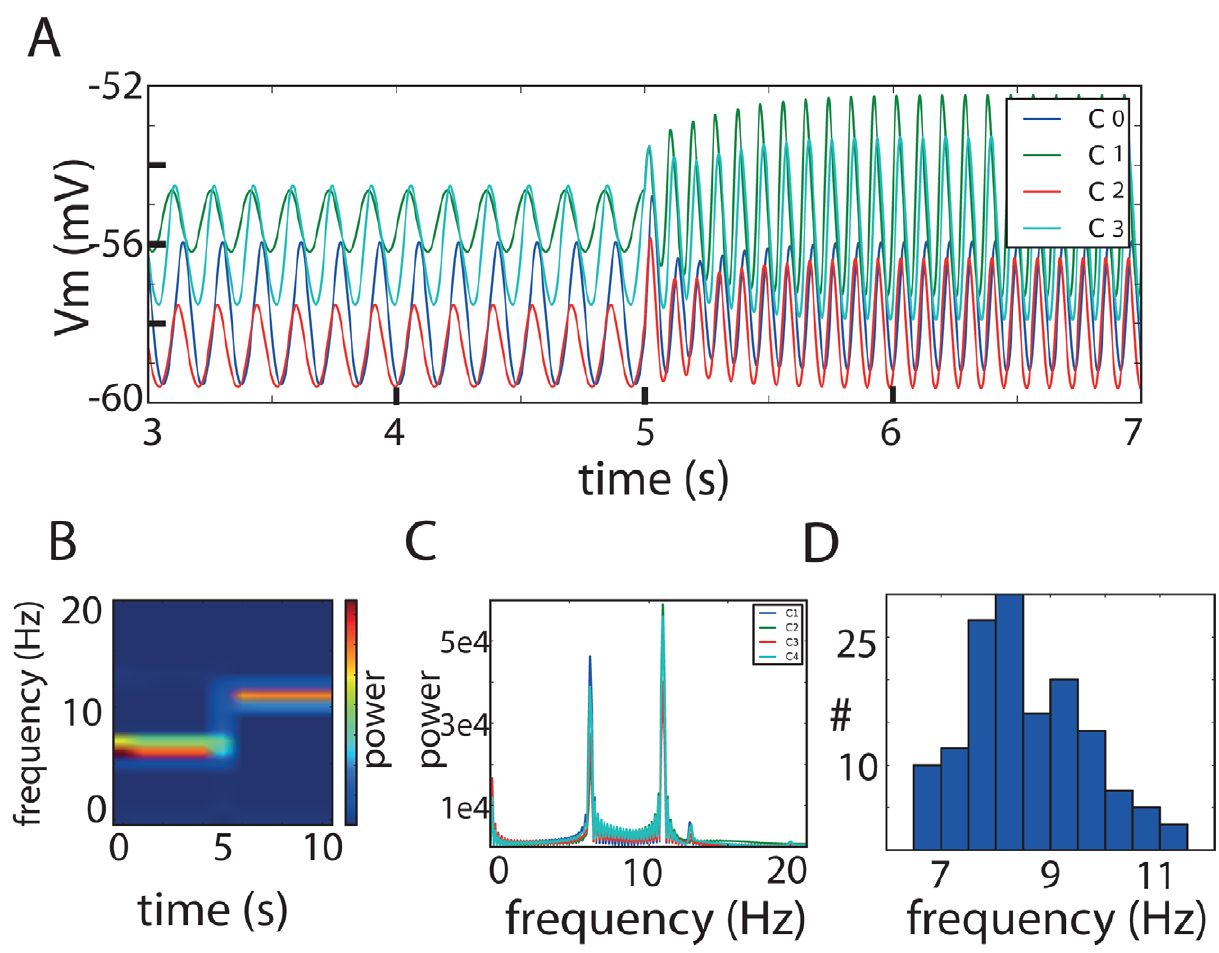
Figure 3. Robust modulation of network frequency by changing the inter-cluster coupling strengths. A: Membrane potential of one neuron per cluster just before and after manually changing the inter-cluster connection strength in the reference network. The change in inter-cluster strength caused a shift in the synchronized oscillation frequency from 6.3 Hz to 10.9 Hz. B: Short-term Fourier transformation of the membrane potential of one neuron in the network indicates the shift in frequency. C: Fourier transformation of the membrane potential of one neuron of each cluster. All clusters oscillate at the same frequency and are subject to the same shift. D: Histogram of frequencies at which the same network with pseudo-random inter-cluster connections strengths can oscillate in synchrony. Only changing the inter-cluster coupling strength (within realistic ranges, i.e., CC , 20%) can be sufficient to bring the network to a state of synchronized oscillations with frequencies between 6 and 11 Hz.